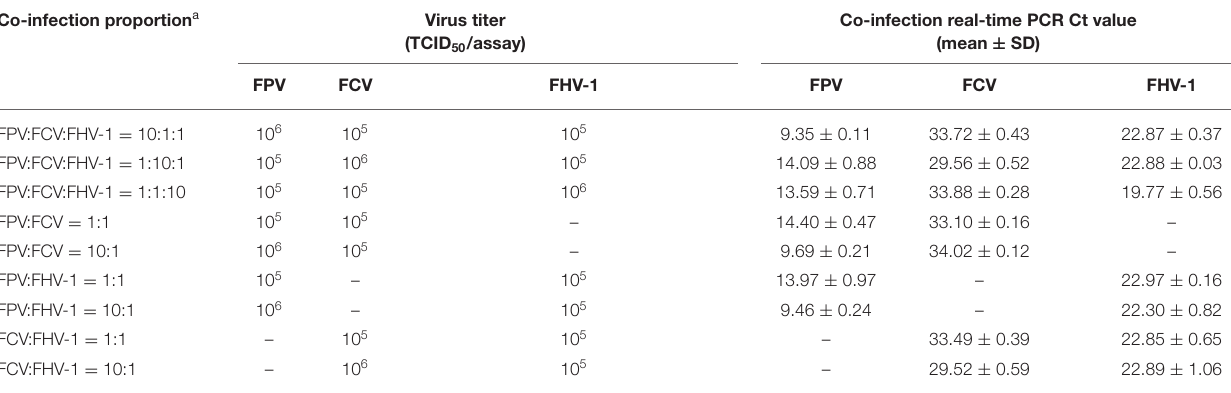
TABLE 4 | Detection of the co-infection models by triplex real-time PCR. Co-infection proportion a